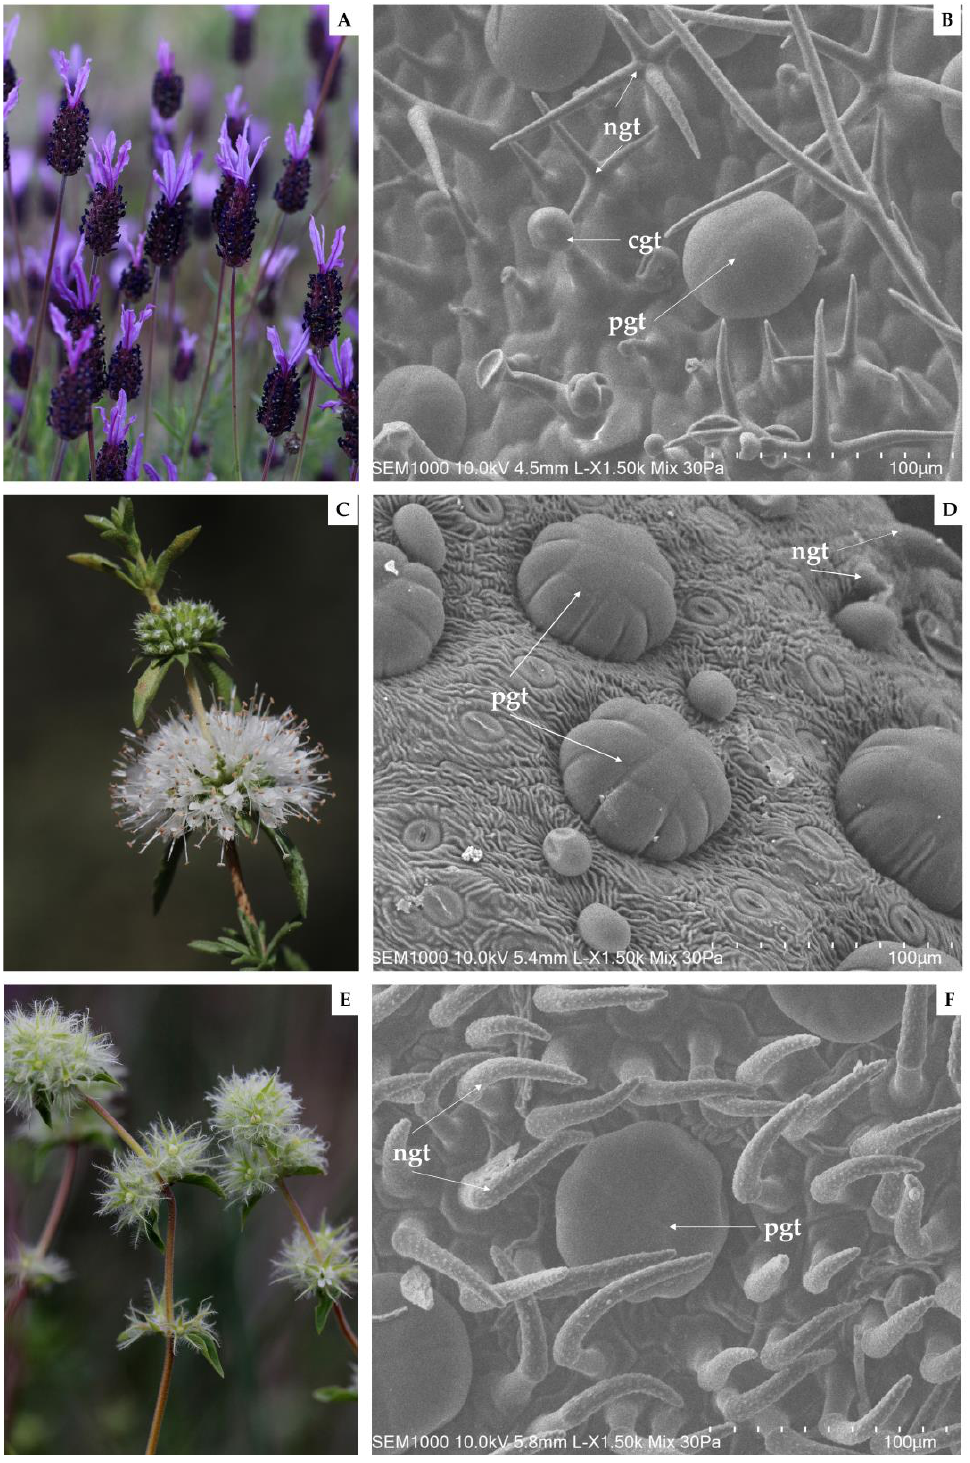
Figure 1. Photographic records of Côa Valley Lamiaceae species in flowering stage and respective scanning electron micrographs captured from their abaxial leaf surfaces, as follows: L. pedunculata ( A , B ), M. cervina ( C , D ), and T. mastichina ( E , F ). Note: cgt — capitate glandular trichomes; ngt — non- ( A , B ), M. cervina ( C , D ), and T. mastichina ( E , F ). Note: cgt —capitate glandular trichomes; ngt —non- glandular trichomes; and pgt — peltate glandular trichomes. glandular trichomes; and pgt —peltate glandular